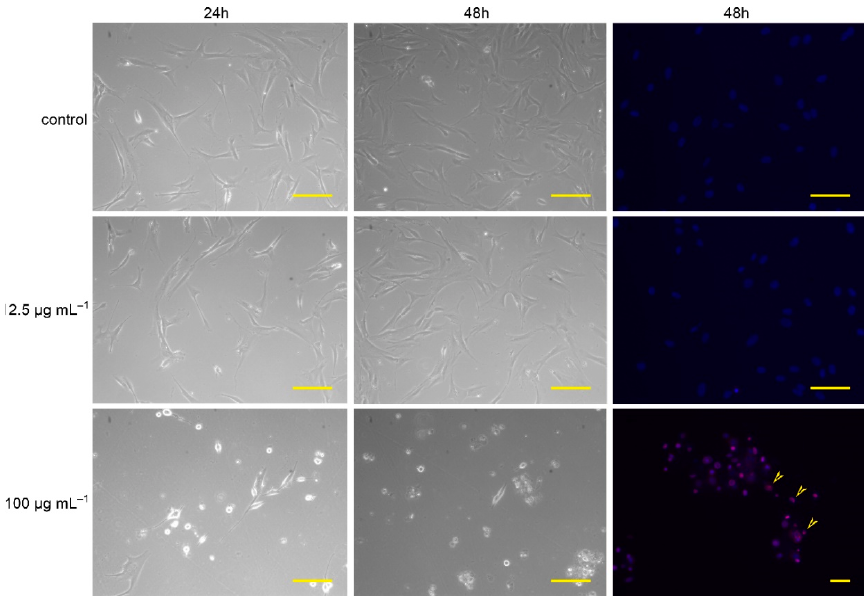
Figure 3. The human skin fibroblast cell morphology. The left column and the middle column show untreated control cells and cells stimulated with C. japonica callus extract at a final concentration of 12.5 and 100 µg mL − 1 after 24 and 48 h of incubation, respectively. The right column shows cells stained with propidium iodide/Hoechst33342 after 48 h of incubation with C. japonica callus extract at a final concentration of 12.5 and 100 µg mL − 1 ; yellow scale bar = 50 µm; yellow arrows indicate the dead cells stained with propidium iodide.